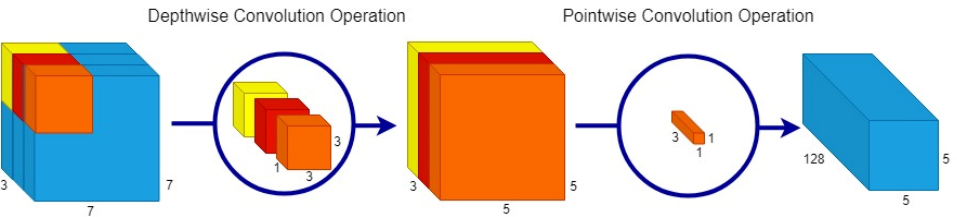
Figure 5. A 3D representation of the efficient Depthwise Separable Convolution (DSC) operation. In this image, DSC operation performs a 3 × 3 depthwise convolution operation on an input image which transforms the image and then performs a 1 × 1 pointwise convolution which elongates this transformed image to over 128 channels. For example, a blue (B) channel from RGB image is elongated only one to obtain different shades of blue channel, instead of transforming the same image multiple times.